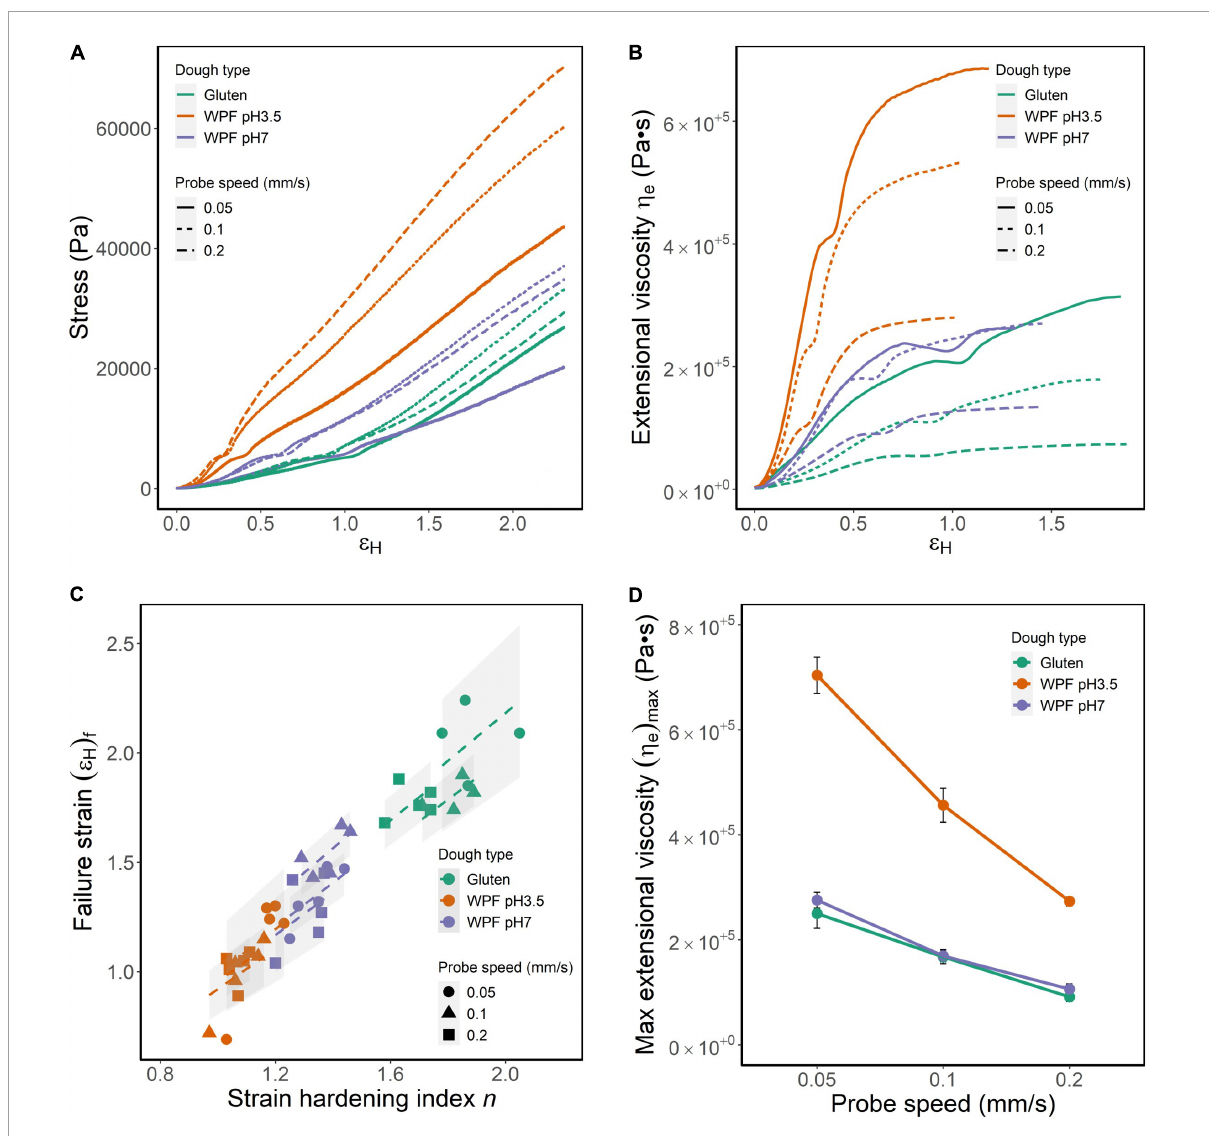
FIGURE6 Strain-hardening parameters of gluten, WPF pH3.5, and pH 7 doughs tested by lubricated squeezing flow method with constant probe velocities of 0.05, 0.1, and 0.2 mm/s. (A) Representative stress–strain curves. (B) Representative curves of stress versus extensional viscosity ( η e ). (C) Dough failure strain [( ε H ) f ] versus strain-hardening index (n). (D) The maximum extensional viscosity during the test as functions of the probe speed. Symbols represent the mean value of ( η e ) max , and error bars are calculated standard